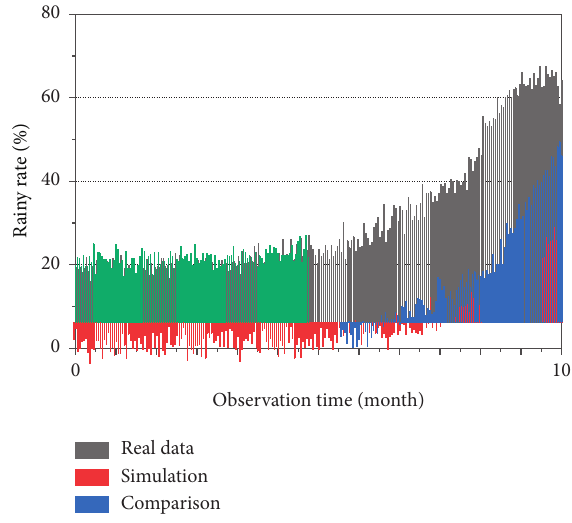
Figure 5: Changes in inland water